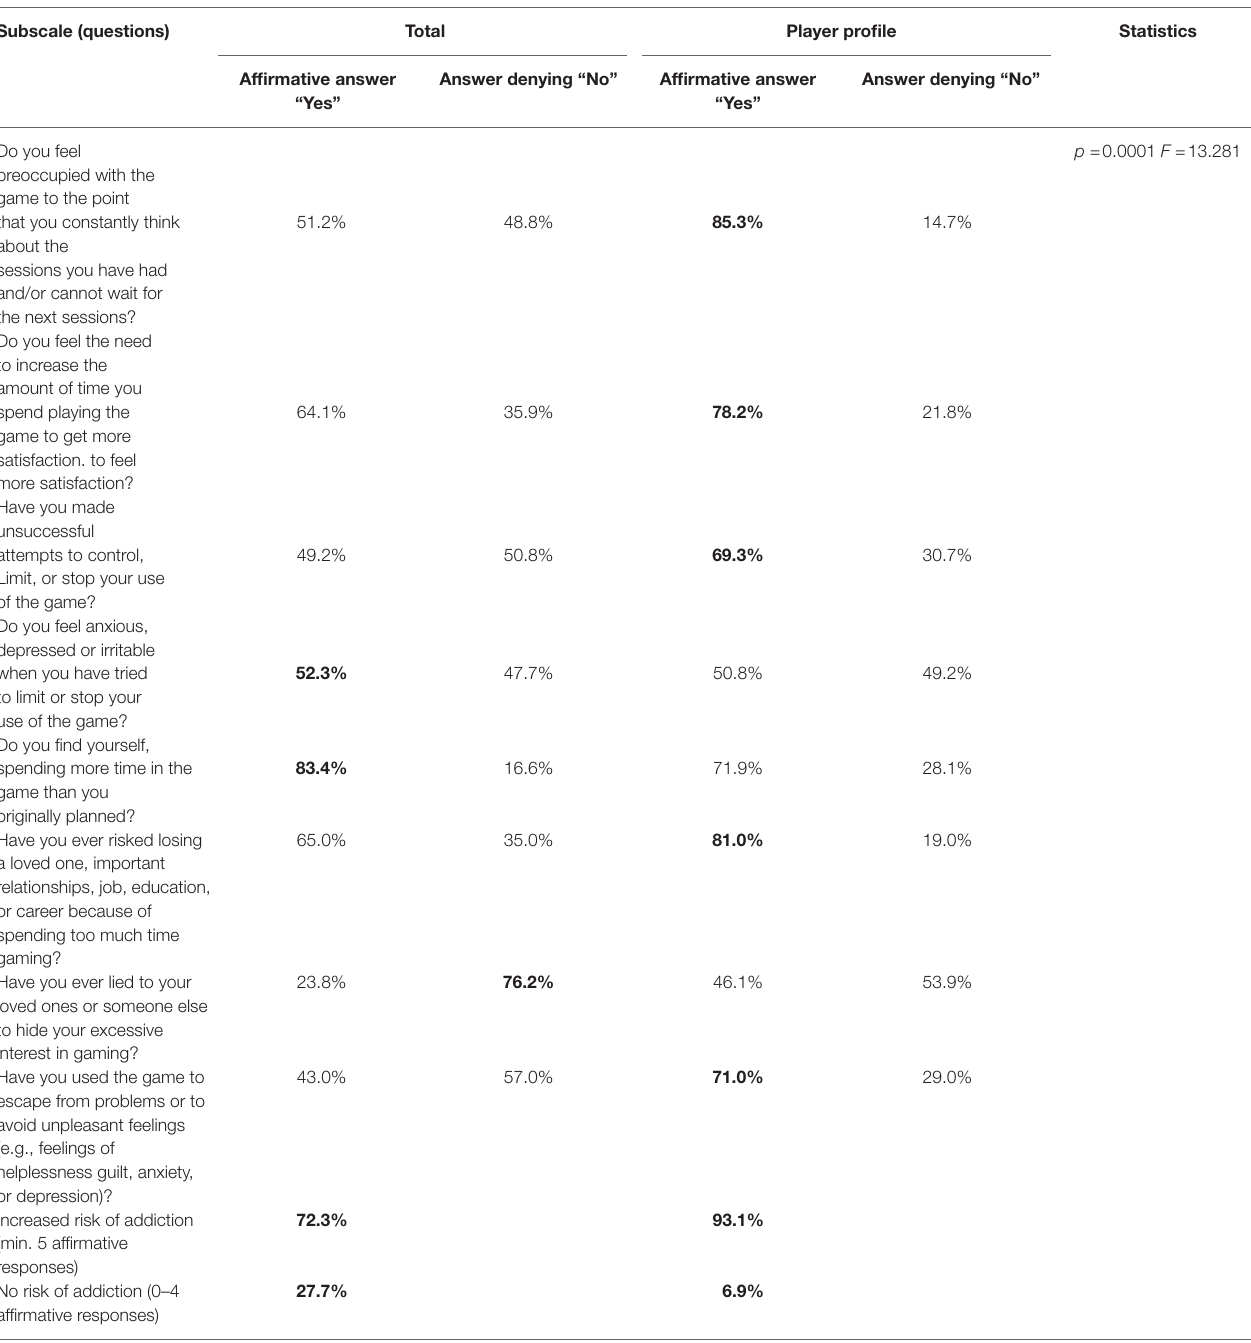
TABLE 4 | Questionnaire of addiction to electronic forms of entertainment. Subscale